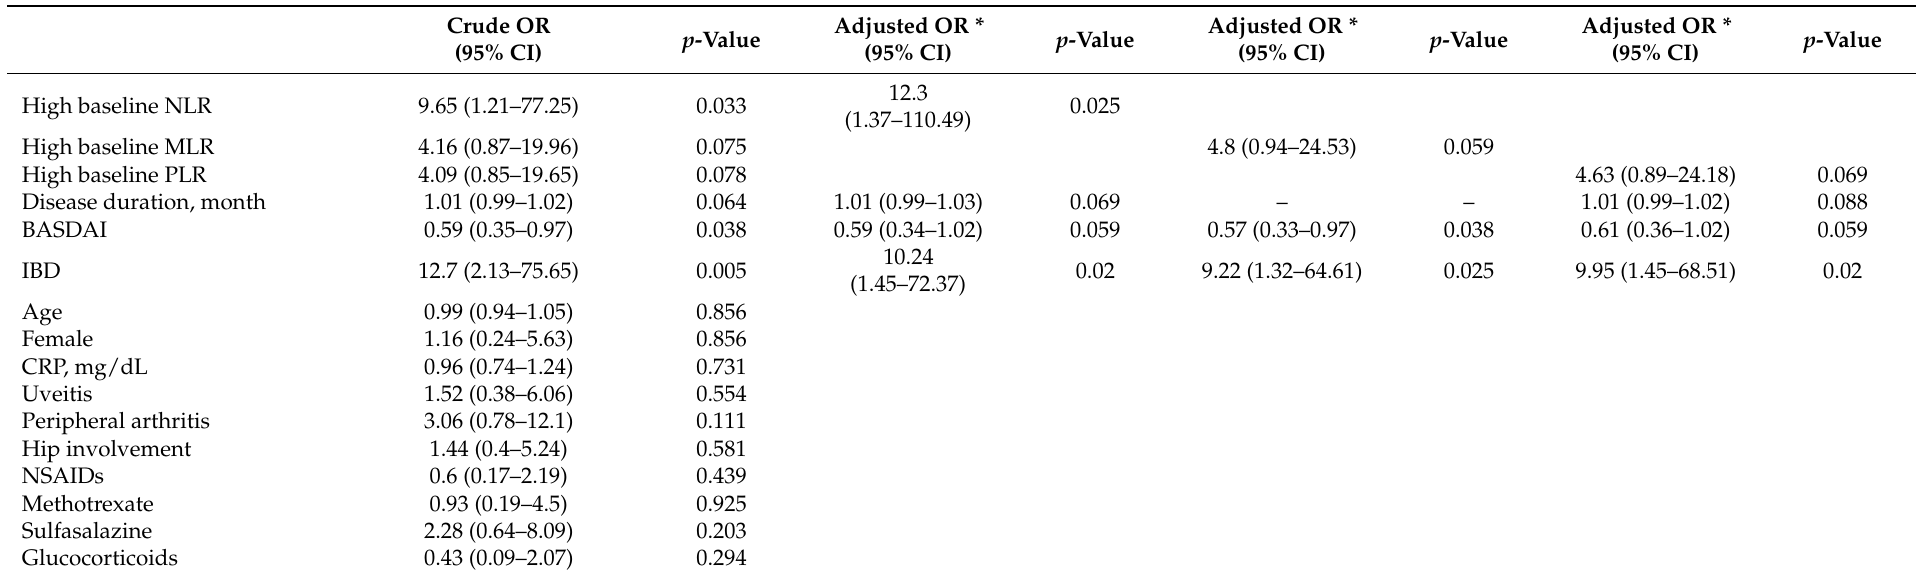
Table 3. Associated factors for non-response to tumor necrosis factor-alpha inhibitors in patients with ankylosing